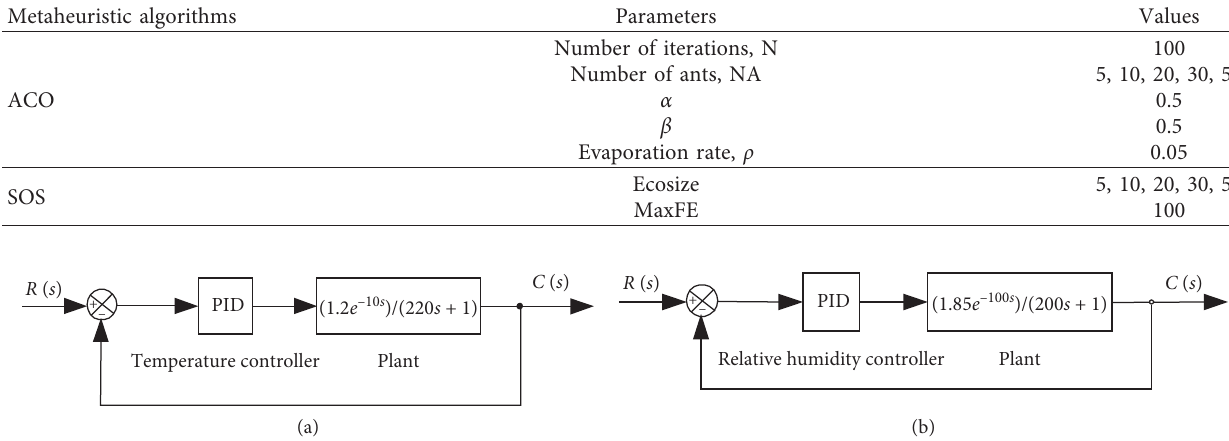
Figure 11: Block diagram of PID controller by the Z-N and pole placement method. (a) Temperature plant. (b) RH plant.